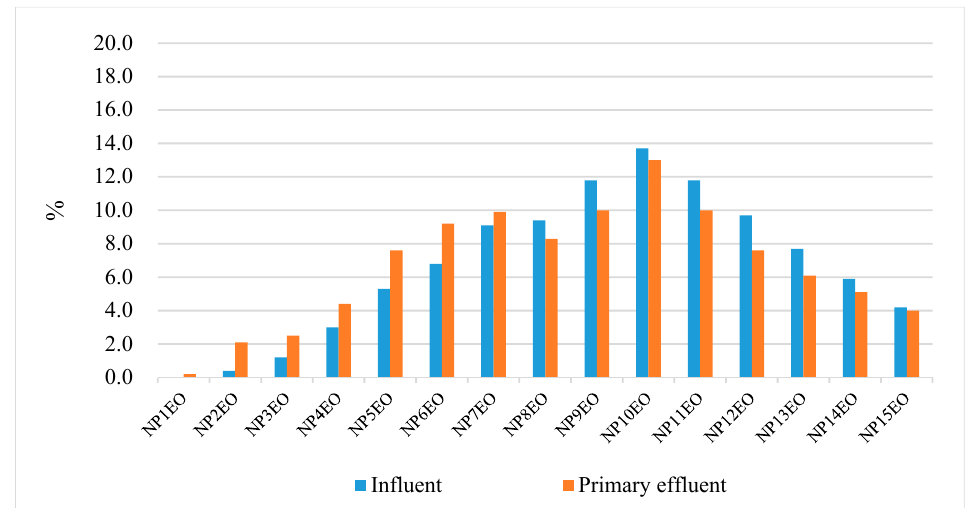
Figure 3. Distribution of nonylphenol ethoxylates for F1.